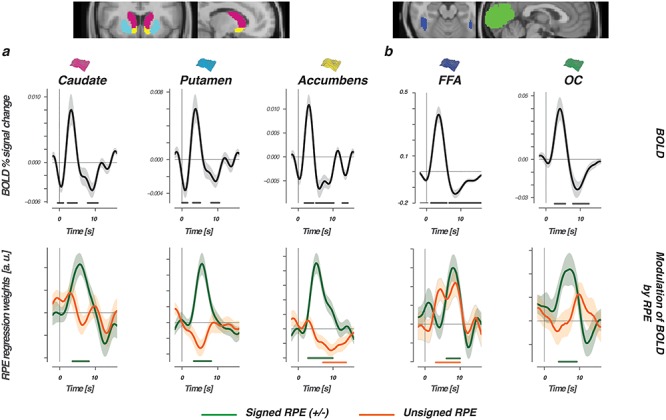
RPEs modulate BOLD in striatal and visual regions. The top row shows the FIR-estimated BOLD signal time course, which was time-locked to the presentation of choice feedback and evaluated for three striatal regions (a) and two perceptual regions (b). Bottom row displays modulations of the estimated BOLD time course by signed (green lines) or unsigned (orange lines) RPEs. The horizontal lines represent the interval in which signed or unsigned RPEs contributed significantly to the modulation of BOLD in the multiple regression. Note that both variables were always evaluated simultaneously in one GLM.